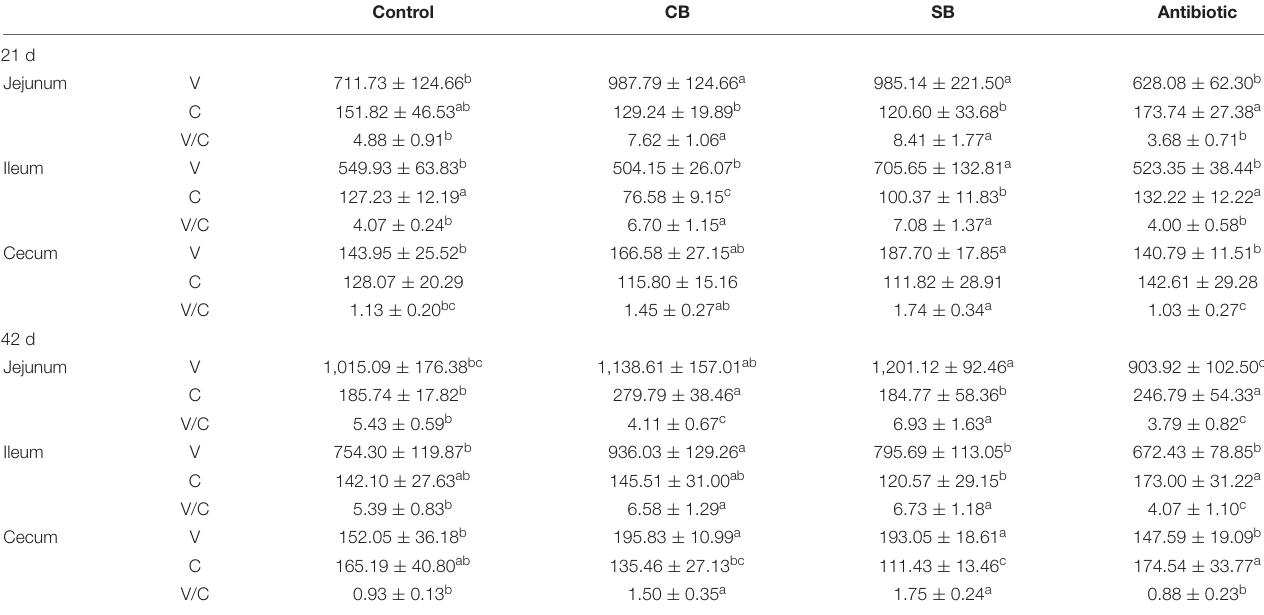
TABLE 4 | Effects of diet on structure of intestinal villi in broilers.